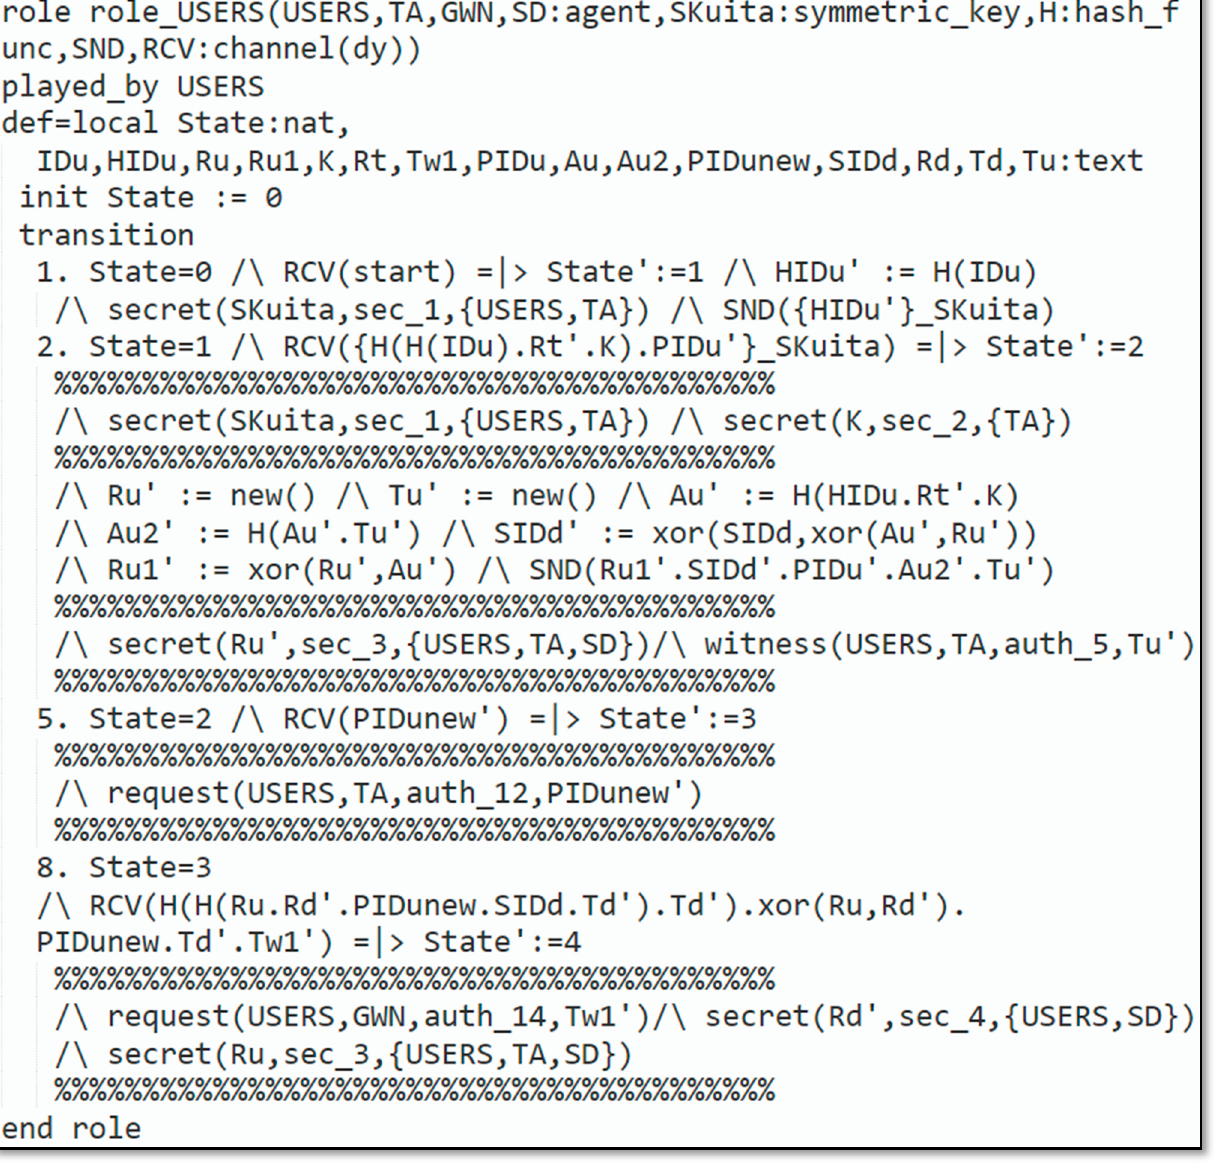
Figure 3. Role specification for the user.